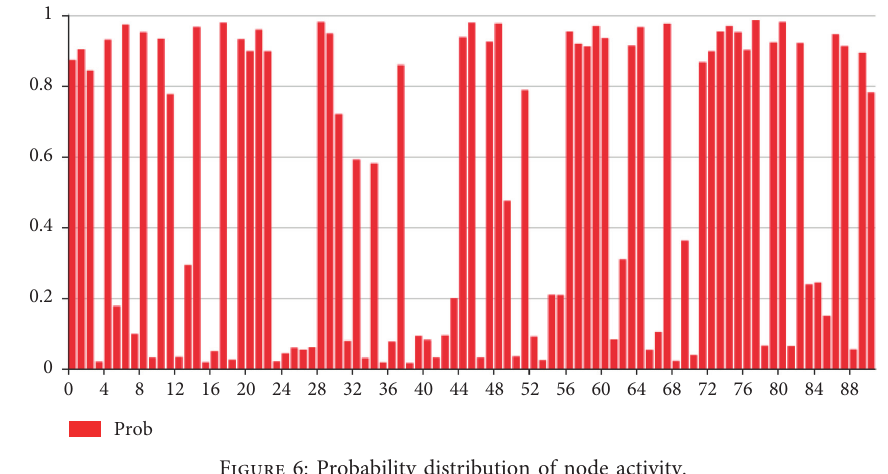
Figure 6: Probability distribution of node activity.